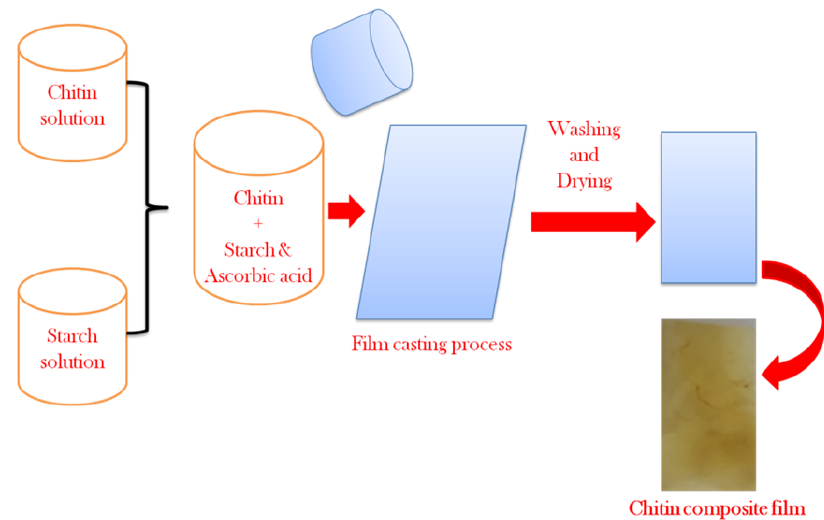
Figure 2. The preparation of chitin film composite.